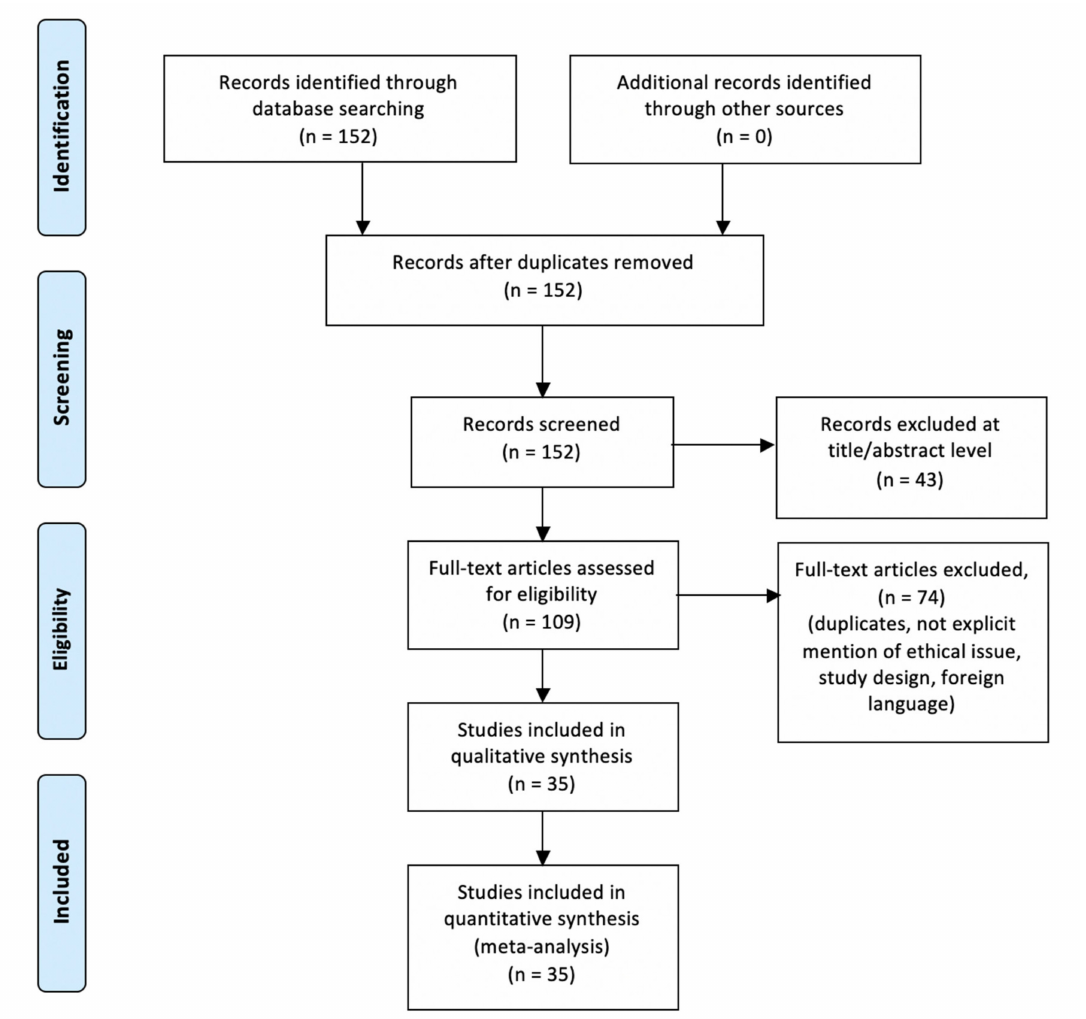
Figure 1. Methodology search strategy: we identified 152 articles, the screening based on their abstract left 109 studies and after a careful evaluation based on the aims of this review 35 research articles were